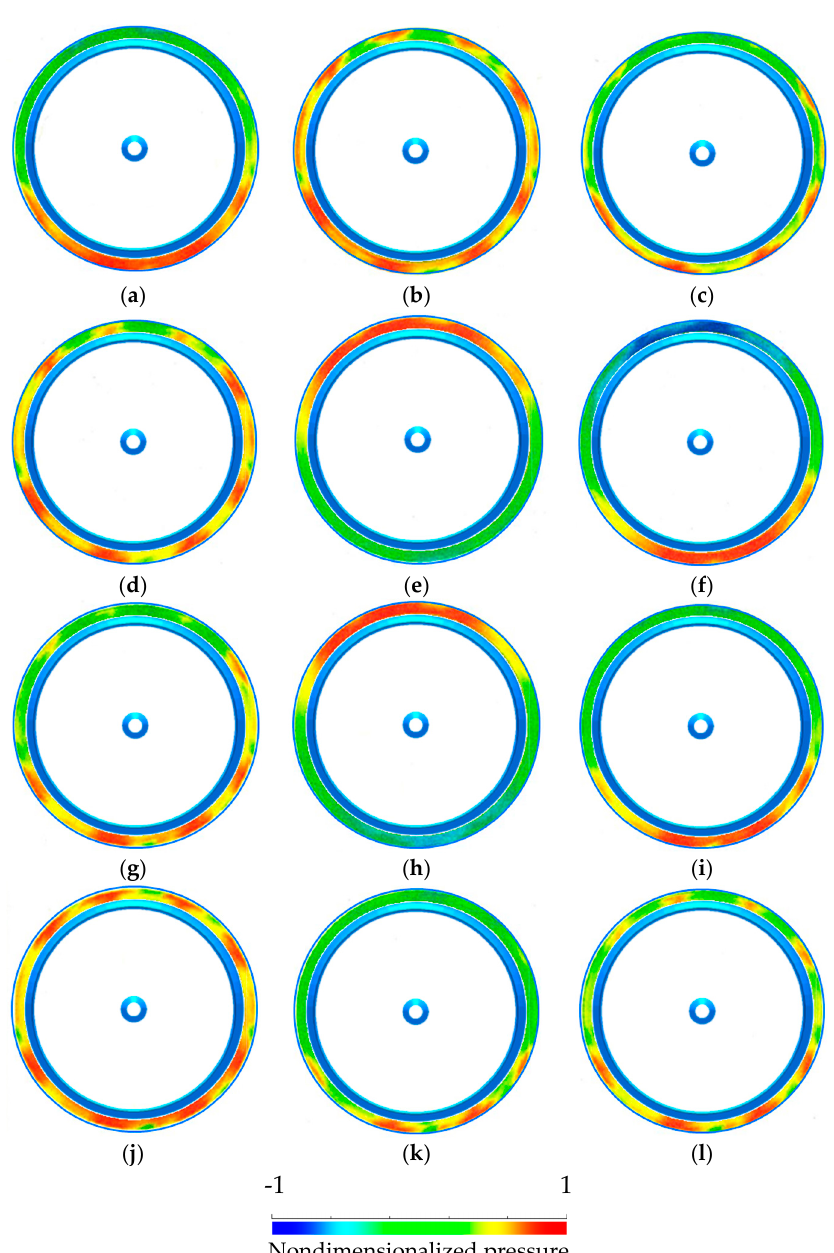
Figure 16. Time-series behavior of instantaneous pressure upon the brim of WLT Ci05. (The nondimensionalized time interval Δ t* between each of the figures was Δ t* = 0.01): ( a ) t * = t 0 * (at the moment 200 Karman vortex cycles have produced behind the brim); ( b ) t = t 0 * + 0.01; ( c ) t = t 0 * + 0.02; ( d ) t = t 0 * + 0.03; ( e ) t = t 0 * + 0.04; ( f ) t = t 0 * + 0.05; ( g ) t = t 0 * + 0.06; ( h ) t = t 0 * + 0.07; ( i ) t = t 0 * + 0.08; ( j ) t = t 0 * + 0.09; ( k ) t = t 0 * + 0.10; ( l ) t = t 0 * + 0.11.